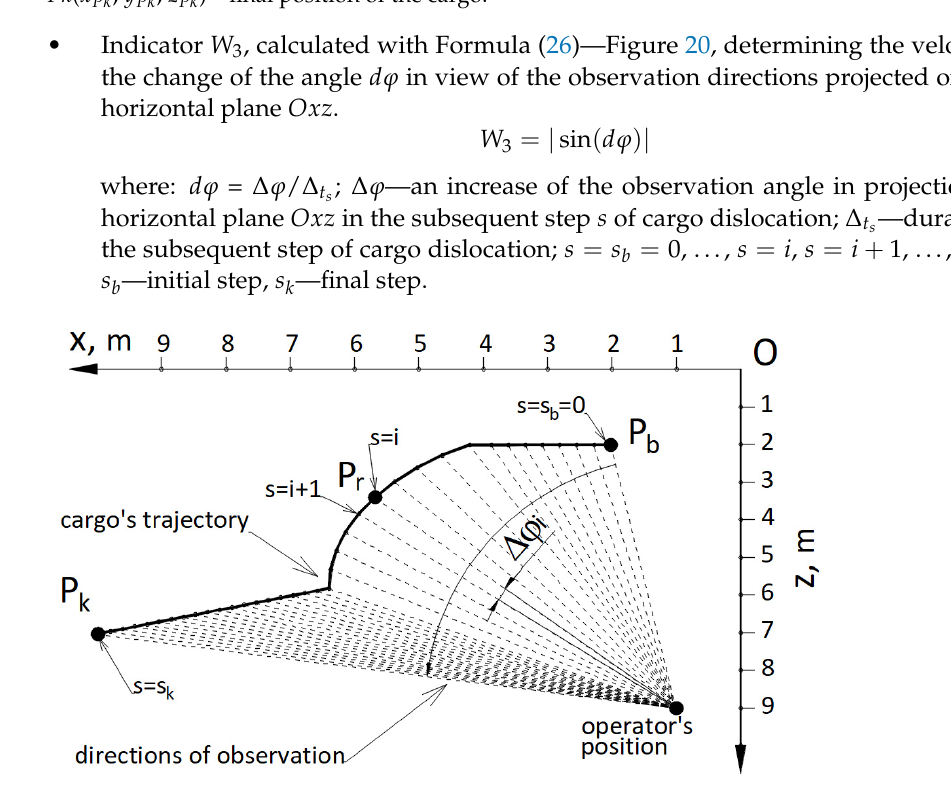
Figure 20. Calculation diagram for the indicator of the accuracy of positioning W 3